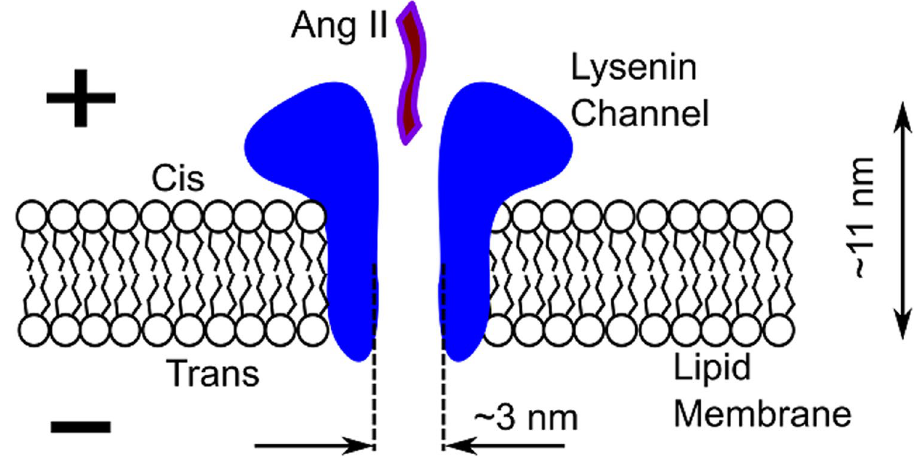
Figure 6. Simplified sketch of the experimental setup for Ang II translocation. Single lysenin channels inserted into planar bilayer lipid membranes biased by transmembrane voltages may facilitate the electrophoretically driven translocation of macromolecules through the large conducting pathway. The channel’s dimensions are from ref.